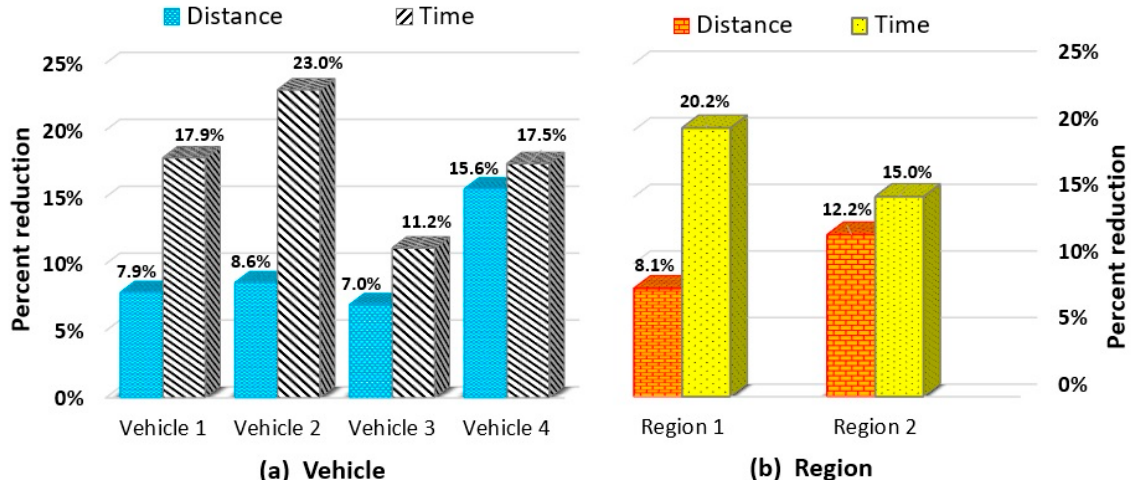
Figure 13. Percent reductions of distance and time for ( a ) each individual vehicle; ( b ) each region.